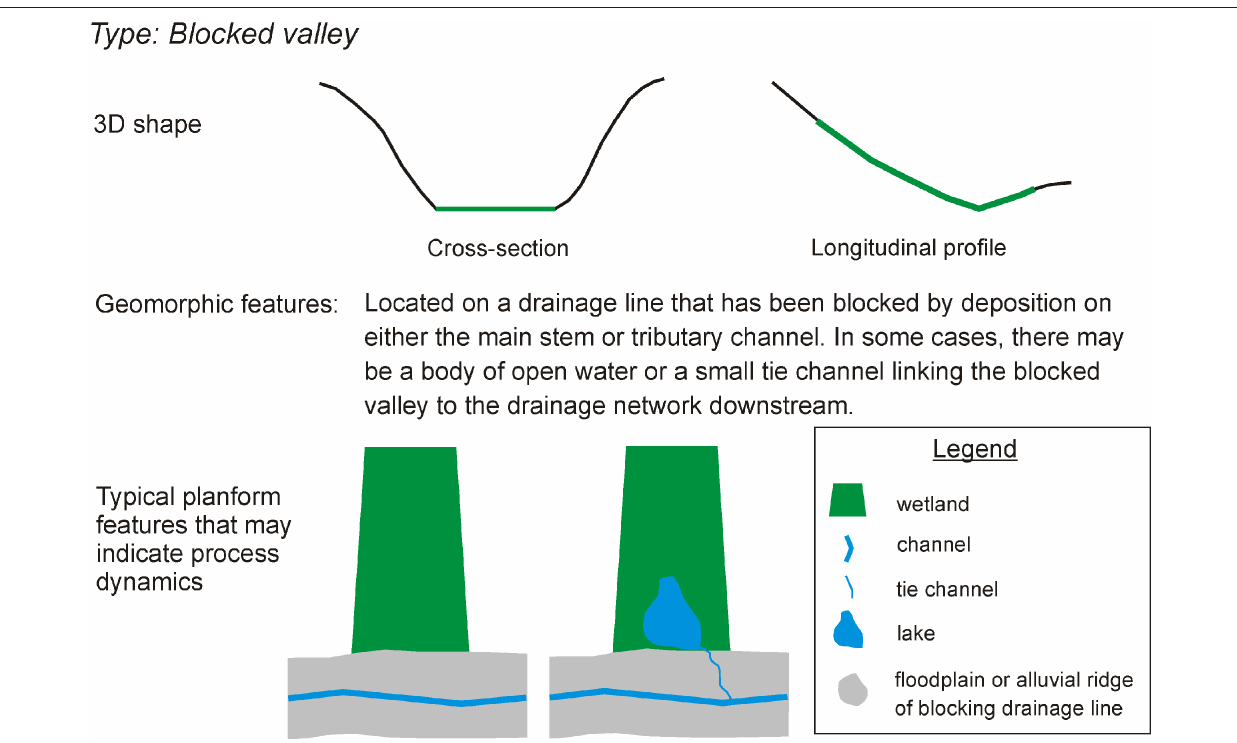
along drainage lines where rates of aggradation on one